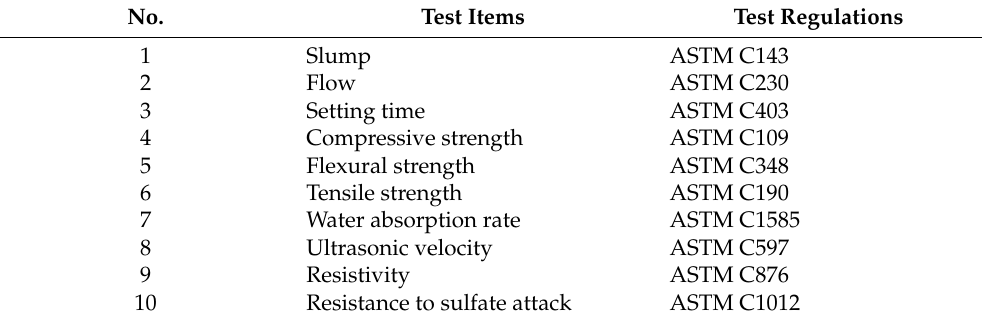
Table 3. Test method and Table 2. Mixture proportions of cement mortar (unit: kg/m 3 ).